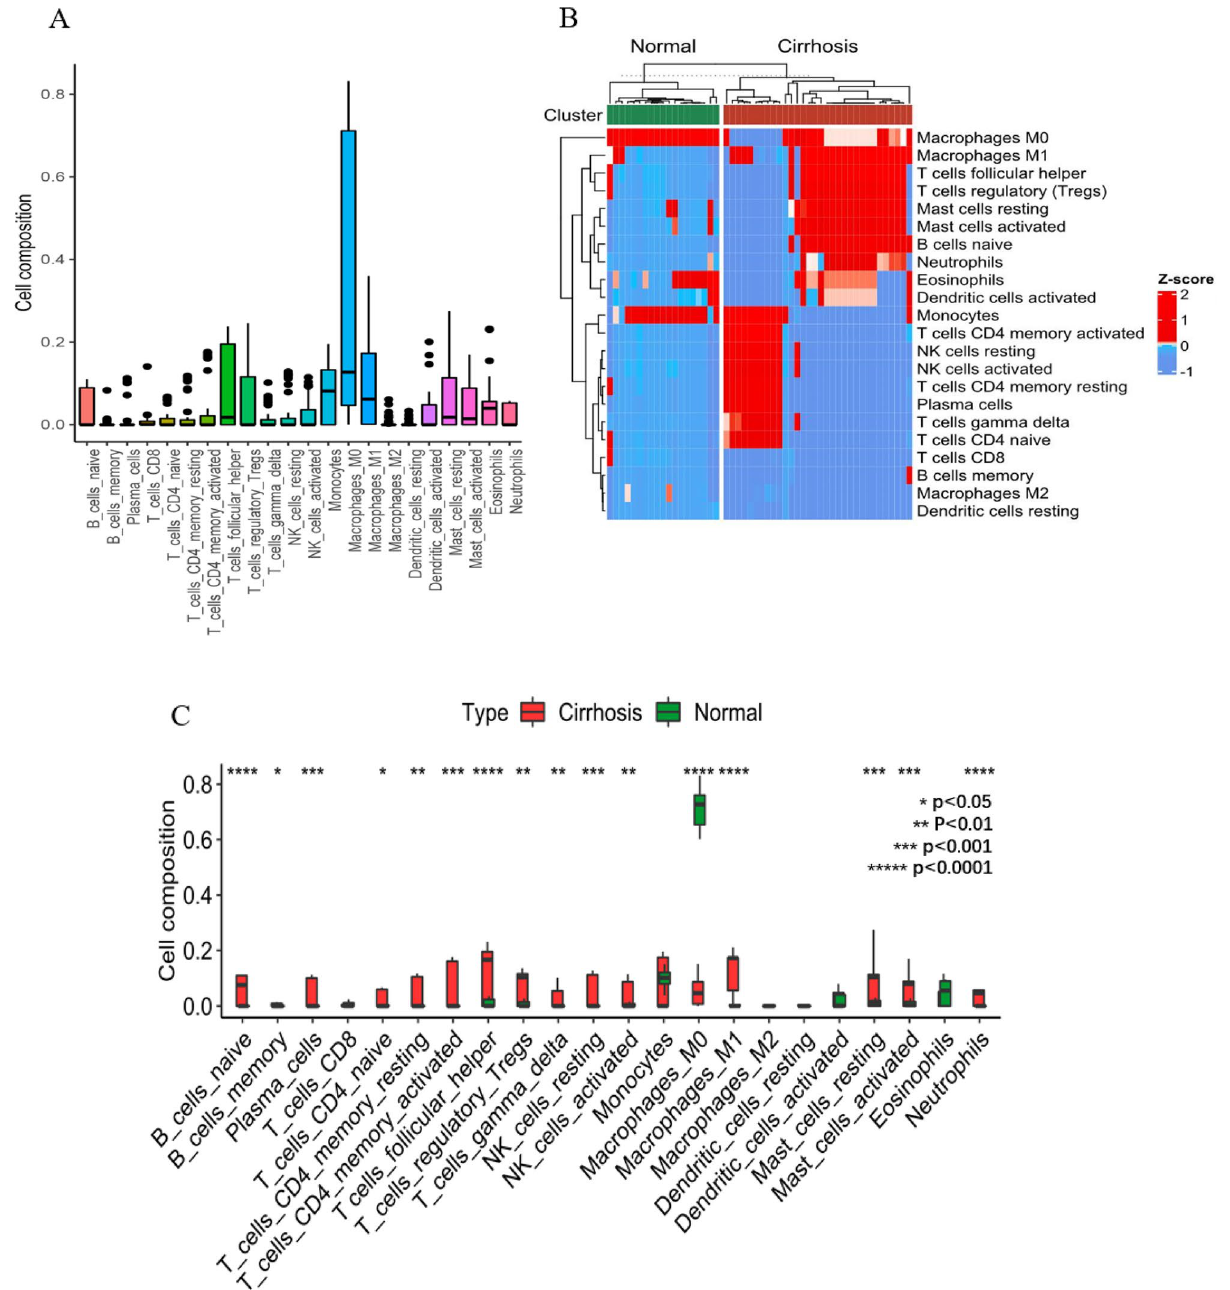
Figure 3. Boxplot ( A ) shows the proportion of 22 immune cells in all samples. Heatmap ( B ) shows the expression change of the 22immune cells between normal liver and cirrhosis samples from two databases. Boxplot ( C ) shows the expression levels of 22 immune cells in normal liver and cirrhosis samples. Red: cirrhosis; Blue: